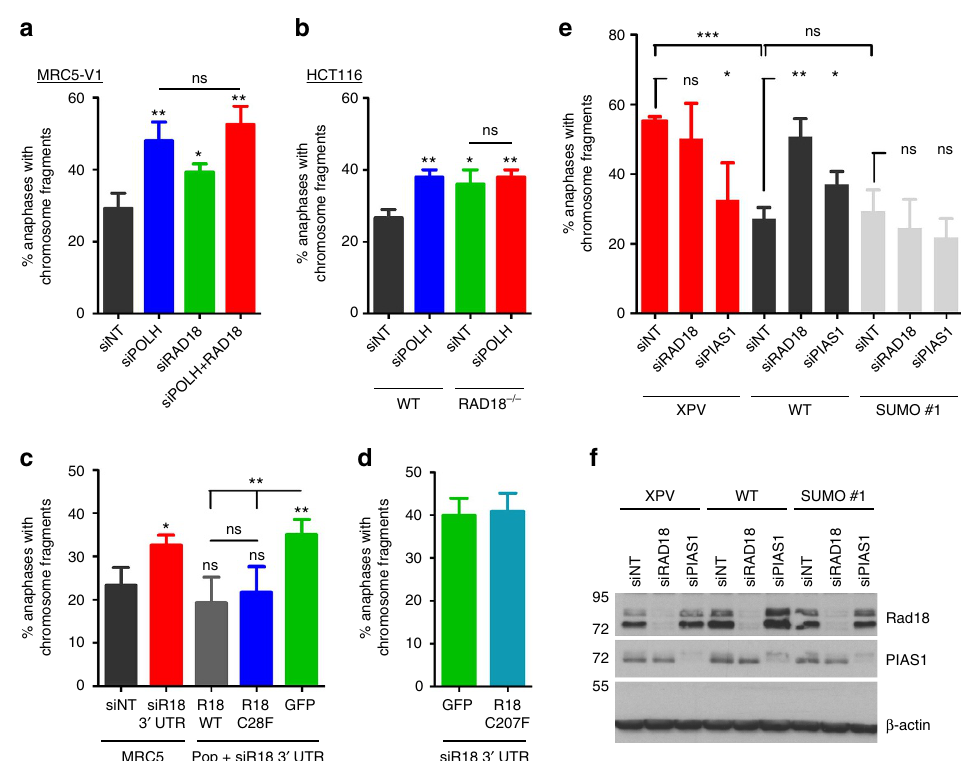
Supplementary Fig. 10d for siRNA efficiency. ( e ) The impact of Rad18 or PIAS1 depletion on the chromosome fragments in anaphase was determined